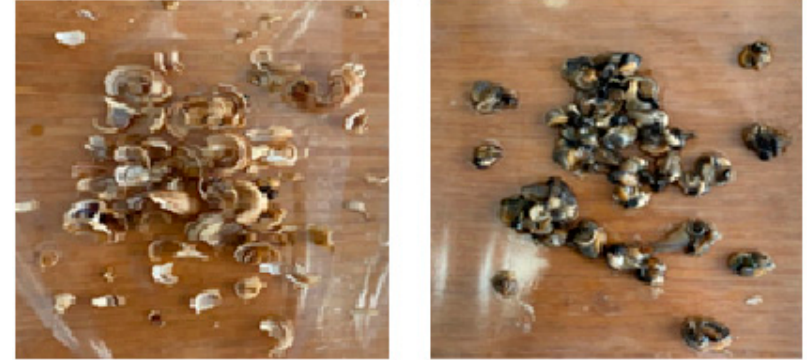
Figure 9. Shell and body parts of grape snails dried at room temperature.